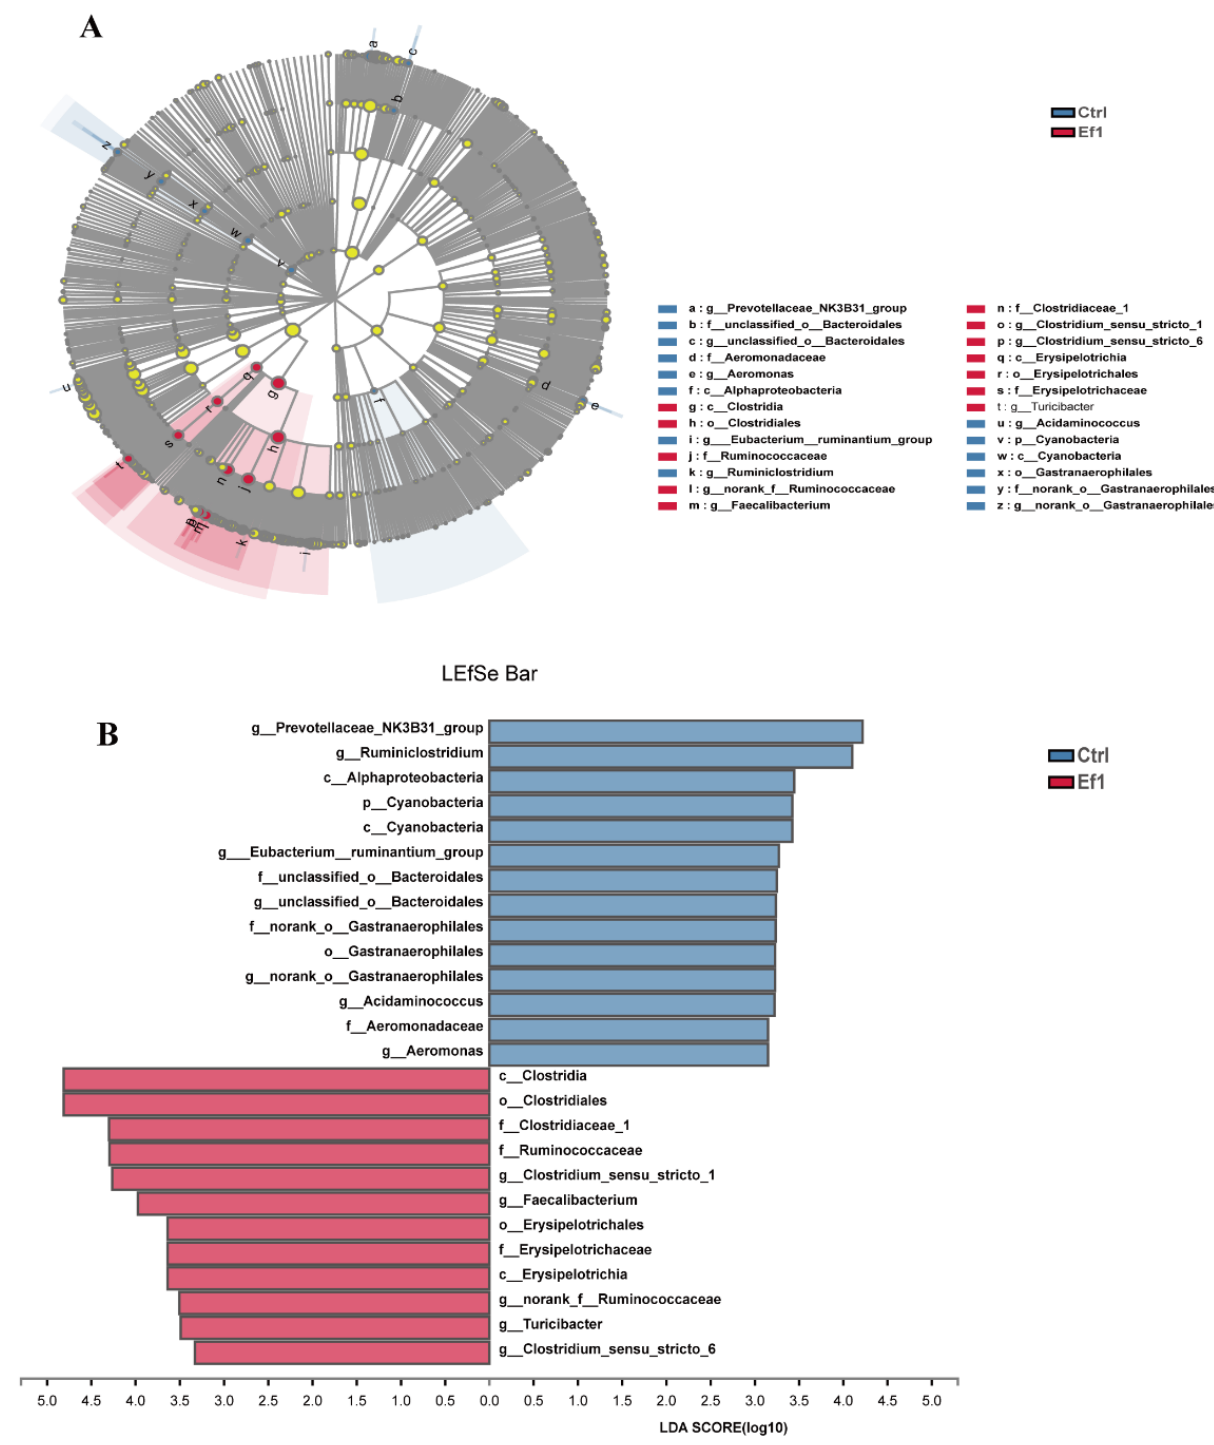
Figure 6. LefSe analysis and LDA score of cecal luminal microbial community from control groups and the HDRsEf1 group. ( A ) Cladogram revealed the microbial taxa with significant differences between the control group and HDRsEf1 group from phyla to genus. The red and blue nodes represent microbial taxa that were enriched in the HDRsEf1 group and the control group, respectively. ( B ) Microbial taxa with LDA score greater than 2.0, the length of the histogram represents the LDA score of the taxa with significant difference. n = 5 per group.